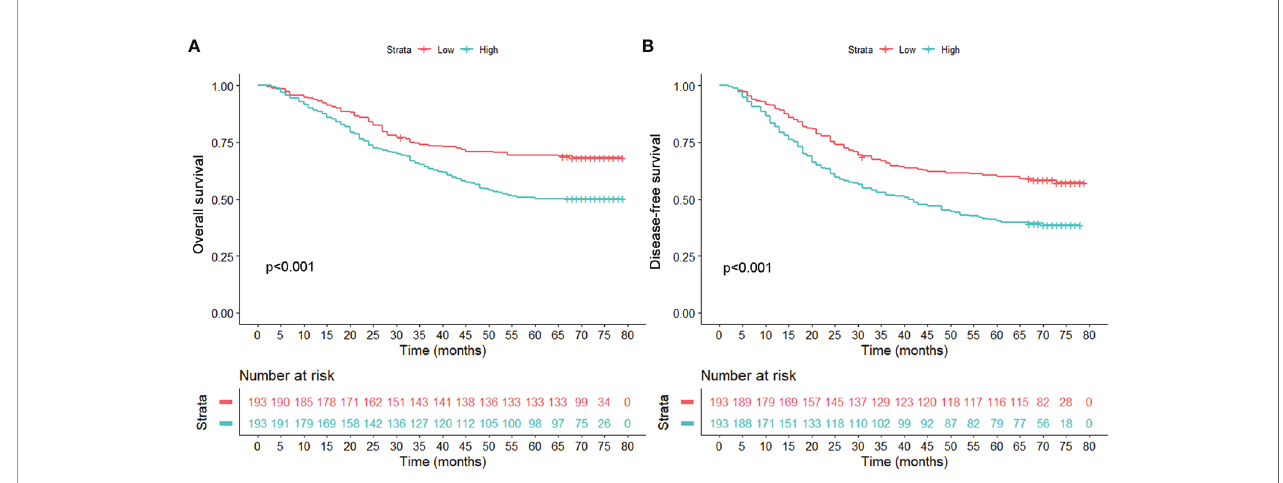
FIGURE 1 | Comparison of overall survival (A) and disease-free survival (B) between patients with high and low serum levels in the unmatched